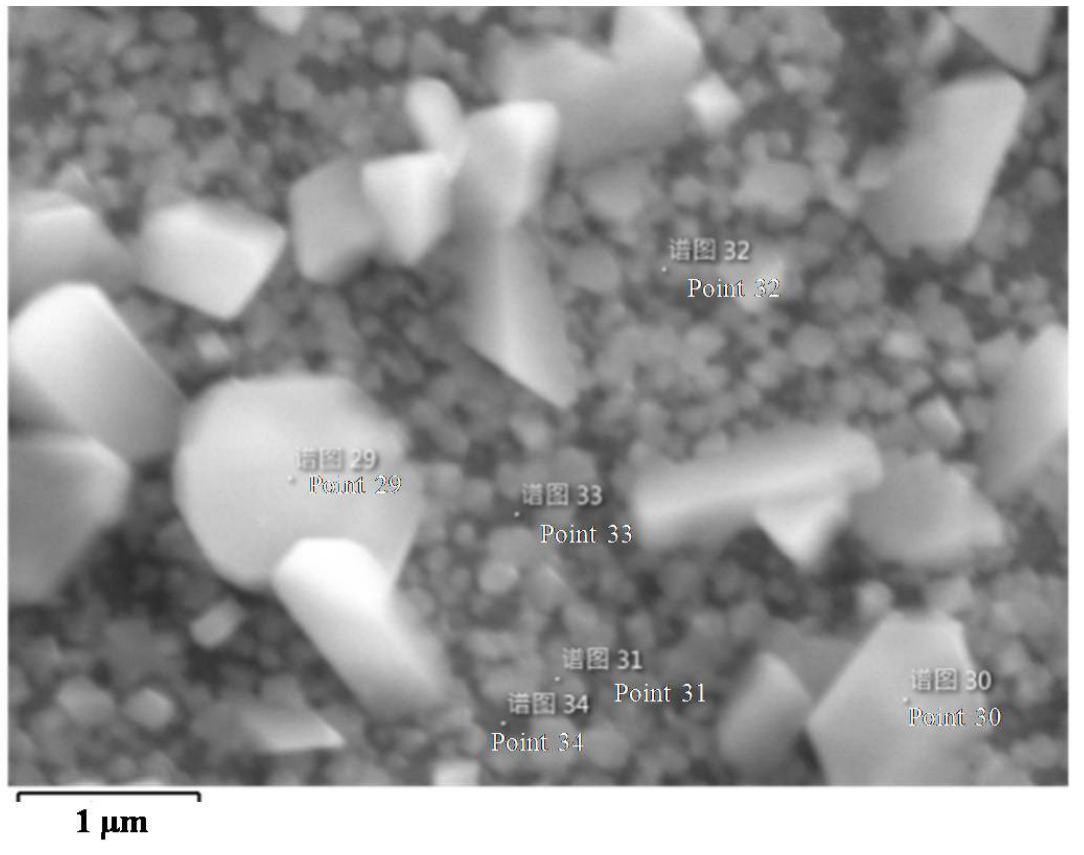
Figure 11. Spot scan of FeCrMnNi alloy after corrosion in 360 °C high temperature and high pressure water environment for 14 days.